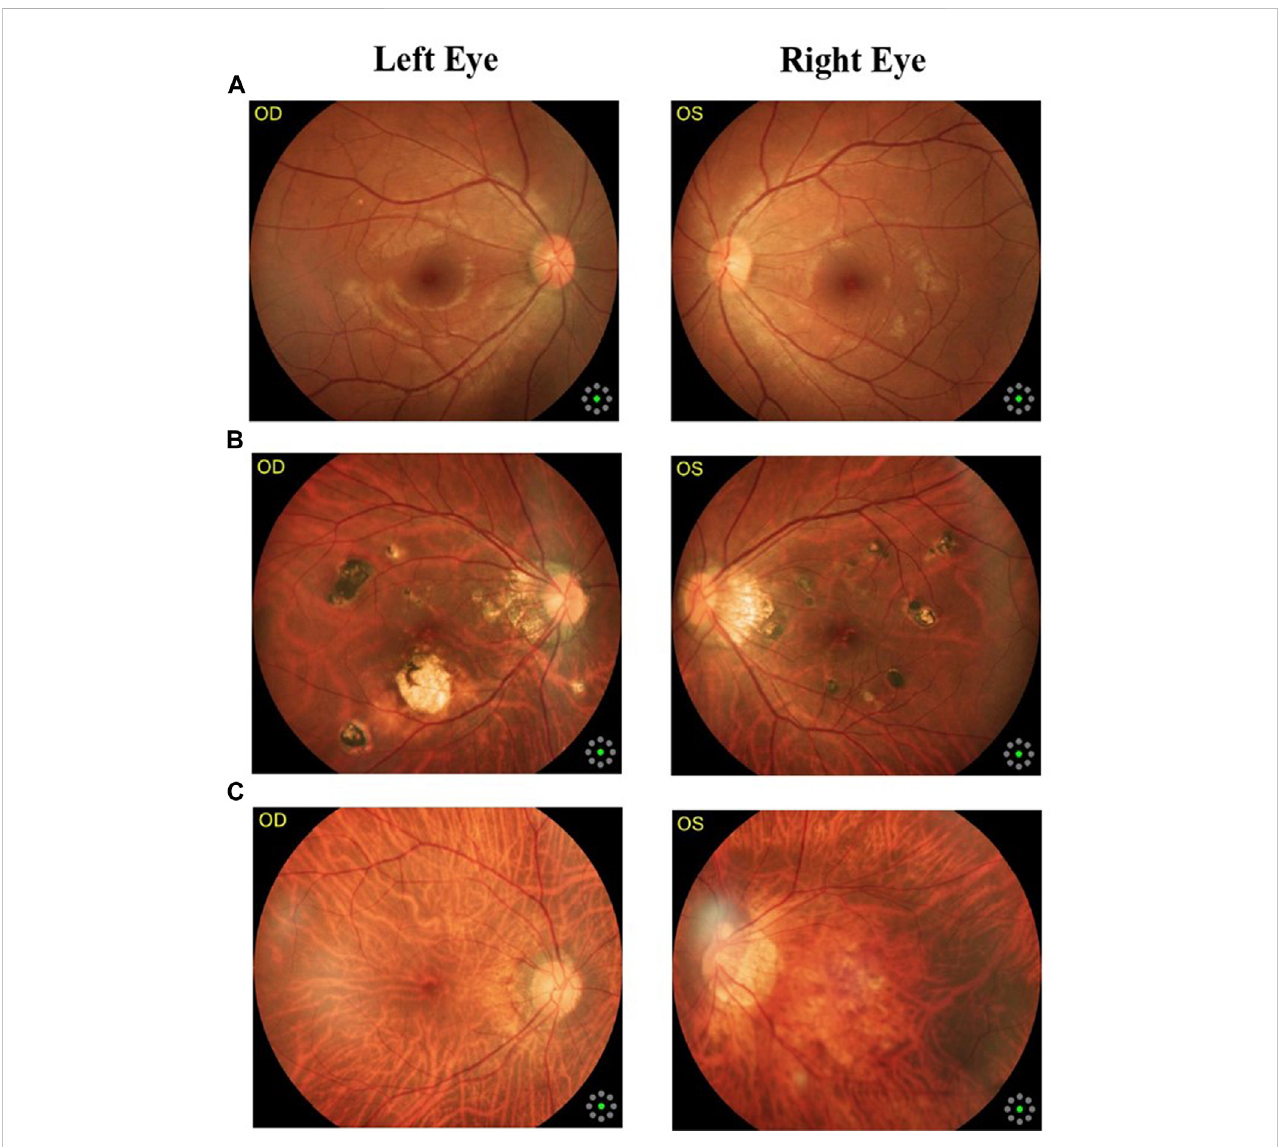
FIGURE 3 Samples of fundus images in various stages. (A) normal, (B) macular degeneration and (C) tessellated fundus.